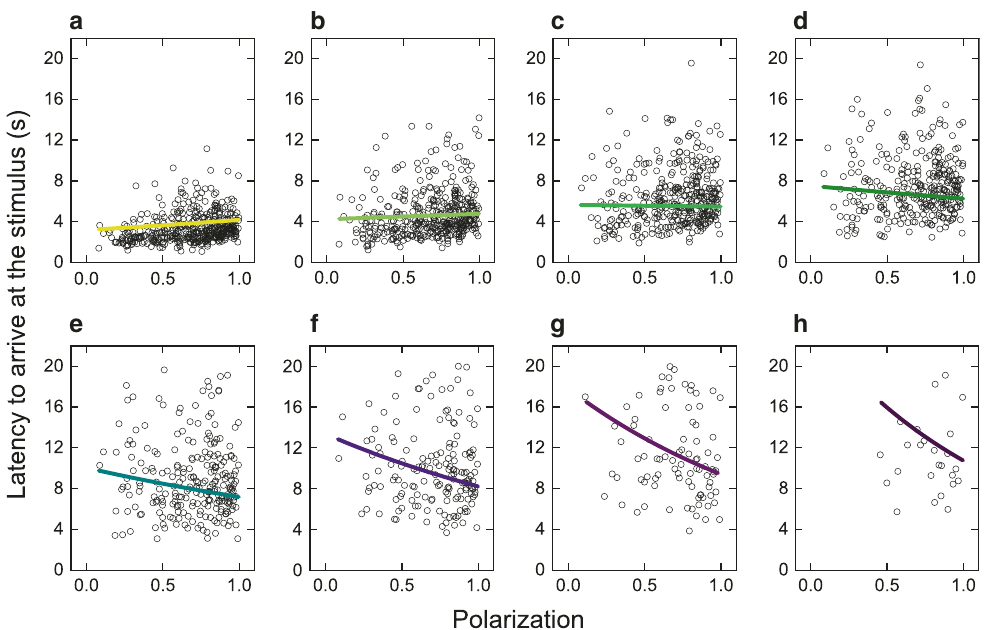
Fig. 3 Variation in collective order affects the latency to arrive at the stimulus. The relationship between group polarization and the latency of an individual to arrive at the stimulus for different orders of arrival. Each panel shows data for fi sh with a different order of arrival at the stimulus: the a fi rst ( n = 428), b second ( n = 406), c third ( n = 376), d fourth ( n = 315), e fi fth ( n = 241), f sixth ( n = 165), g seventh ( n = 87) and h eighth ( n = 25) fi sh across presentations and trials (sample sizes are after the exclusion of n = 48 outliers from the model, see Methods). Points show the arrival latency of individual fi sh plotted against the median polarization of their group in the 0.5 s (13 frames) prior to the presentation. Lines show the predicted relationship between polarization and latency to arrive at the stimulus in each case, generated from a LMM (see Methods). The latency to arrive at the stimulus was calculated up to a maximum of 20 s (500 frames) following a presentation to capture responses to the stimulus only (see Methods). Hence, sample size for the sixth, seventh and eighth fi sh is small. However, a strong interaction effect between polarization and arrival order is apparent even when considering only the fi rst to fi fth fi sh to